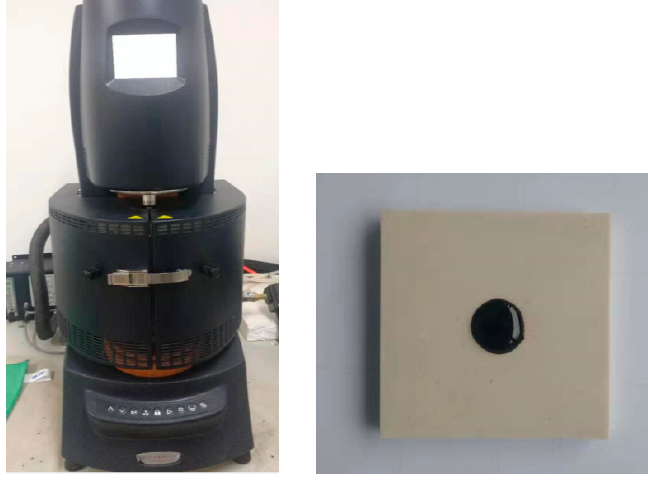
Figure 2. Test equipment and samples.